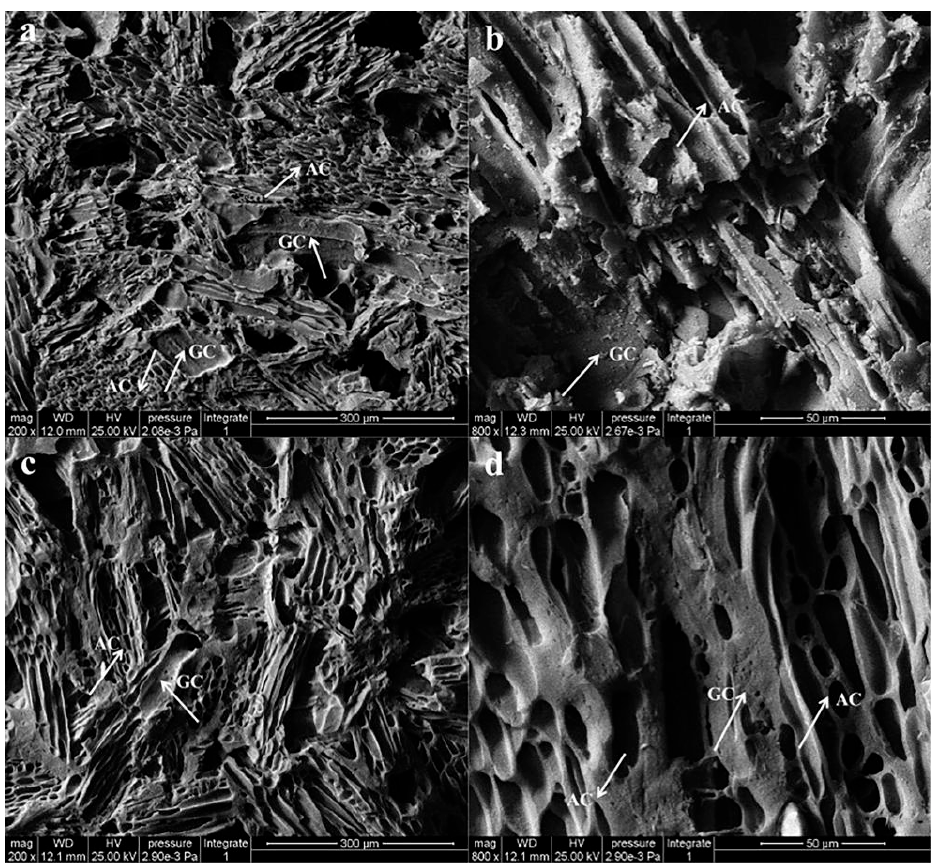
Figure 5. ( a , b ): UT-WCS; ( c , d ): HT-WCS ( a , c ): magnified 200 times; ( b , d ): magnified 800 times) (AC indicates amorphous carbon from wood powder and GC indicates glassy carbon from phenolic resin). After being sintered at 1000 °C, partial glassy carbon, which comes from phenolic resin, is keeping moving on with continuous structure, and the phenolic resin-poplar powder is carbonized into WCS. Figure 5a,c figured that the carbonized wood powders get in touch with other through forming glassy carbon bridges. HT-WCS (WCS made from heat-treated wood) exhibits denser and smoother surface along with more pores. As shown in Figure 5a, UT-WCS (WCS made from untreated wood) is of heterogeneous laminated microstructure due to untreated wood powder, which tends to aggregate into smaller particles or even agglomerate when mixed with phenolic resins. This is determined by the higher density and the compact structure of wood powder. The glass carbon produced by phenolic resin is separated from the amorphous carbon produced by wood powder. However, HT-WCS exhibits a topologically uniform microstructure. The phenolated wood carbon formed a continuous part, and the interconnected open form network structure is obvious. Small glassy carbon regions are dispersed among the wood carbon particles, as shown in Figure 5c,d. Glass carbon originating from phenolic resin and amorphous carbon originating from wood powder grow together, and the interface gradually disappears. The lower density and moisture content and looser structure facilitate the mixing of heat-treated wood powder with phenolic resin. As a result,